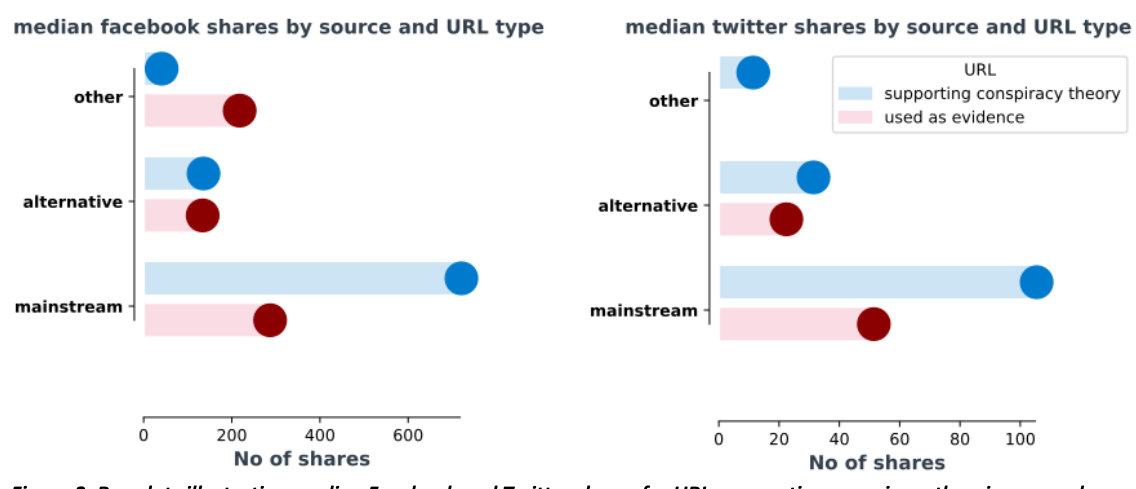
Figure 2. Bar plots illustrating median Facebook and Twitter shares for URLs supporting conspiracy theories or used as evi- dence by source type. Mainstream sources included scientific articles, patent repositories, Wikipedia, government websites, high credibility and widely acceptable media outlets. Alternative sources included media outlets defined as low credibility. Other sources included social media submissions from Facebook, YouTube, Twitter, and Reddit, or personal websites and blogs. Table 1. Exemplary URLs from the dataset. The table includes the title of the URL, its source, the assigned source label, content label, and the number of Facebook and Twitter